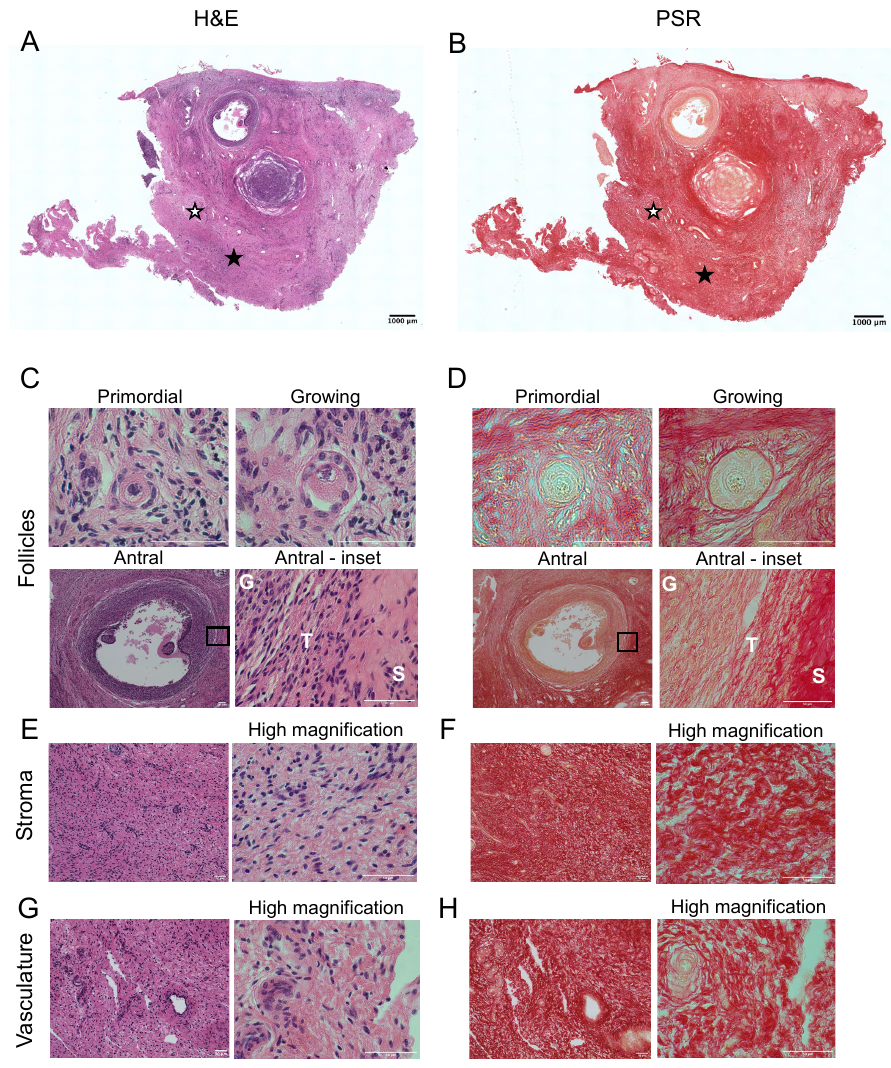
Figure 1. Picrosirius red staining detects collagen in bovine ovarian follicles, stroma, and vasculature. Hematoxylin and eosin (H&E) staining ( left ) and picrosirius red (PSR) staining of bovine ovarian tissue sections ( right ). ( A ) H&E staining illustrates the microanatomical structure of a bovine ovarian tissue section. ( B ) PSR staining localizes collagen (red) in a section sequential to that of the one seen in ( A ). H&E and PSR staining in ( C , D ) primordial follicle, growing follicle, and antral follicle, ( E , F ) stroma, ( G , H ) vasculature, respectively. The area demarcated by the black rectangles in low magnification images ( C , D —Antral follicle) is shown in higher magnification images to the right. High magnification images of stroma ( E , F ) and vasculature ( G , H ) are seen to the right of each low magnification image. G—granulosa cell layer, T—theca cell layer, S—stroma. The scale bars in ( A , B ) are 1000 µ m and in ( C – H ) are 50 µ m. Images are representative of bovine ovaries ( n = 2 cows, n = 1 ovary/cow, n = 2 sections/ovary). White stars indicate location of vasculature, while black stars indicate location of the